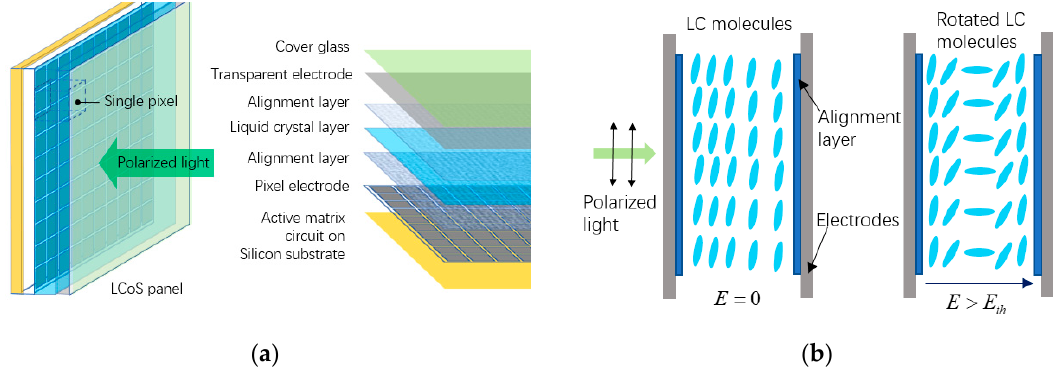
Figure 1. ( a ) Basic structure of LCoS. ( b ) Schematic of zero-twisted ECB mode-based LC cell in ON and OFF states. LC: liquid crystal; E th : threshold of the electric field